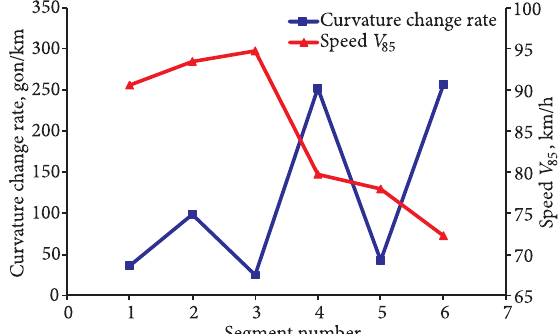
Fig. 8. The course of curvature change rate and speed on studied road